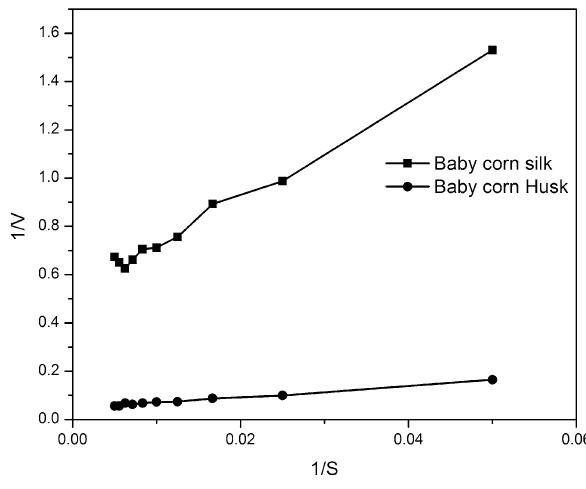
Fig. 9 Lineweaver–Burk plot for silk and husk